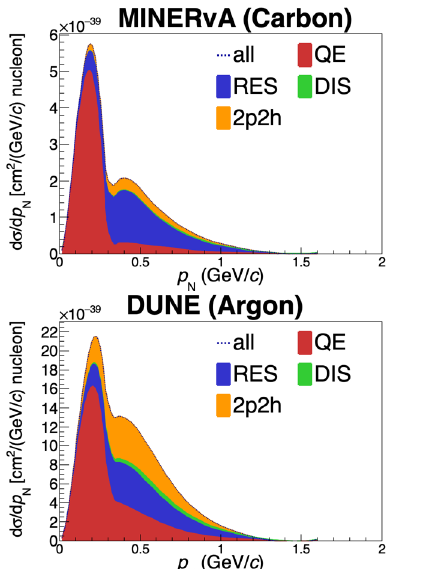
Figure 153. Differential cross section in the emulated nucleon momentum, p n , for MINERvA ( left ), as studied in [42], and for argon ( right ) in ND-GAr. The middle plot is for a carbon detector with the acceptance of ND-GAr to separate the detector design from the nucleus for the